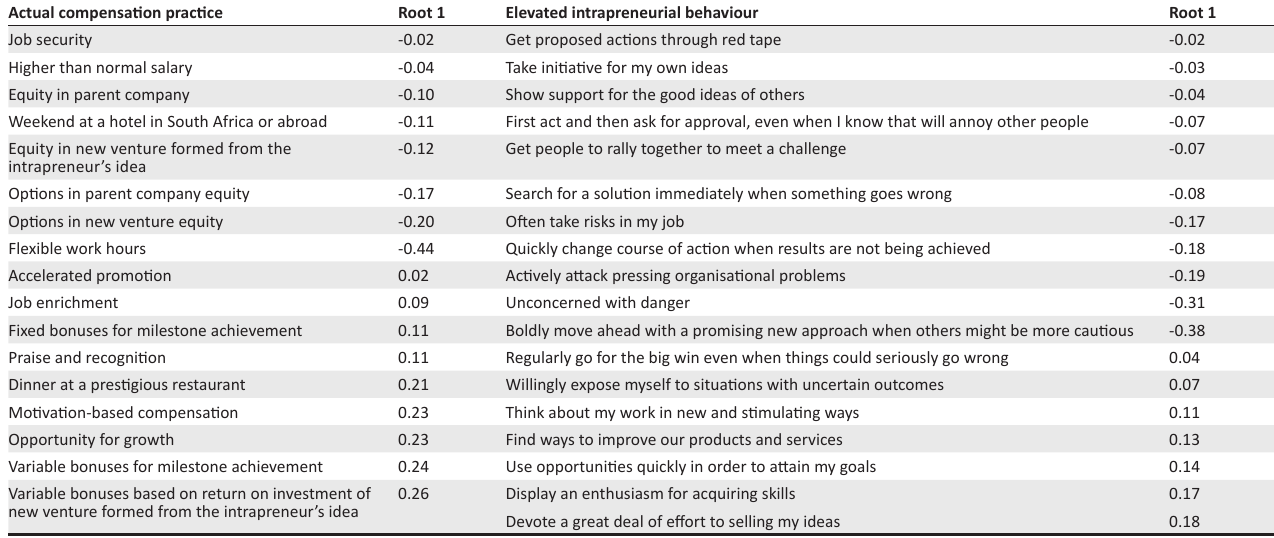
TABLE 2: Hypothesis 1: Canonical analysis on actual compensation practices and elevated intrapreneurial behaviour.